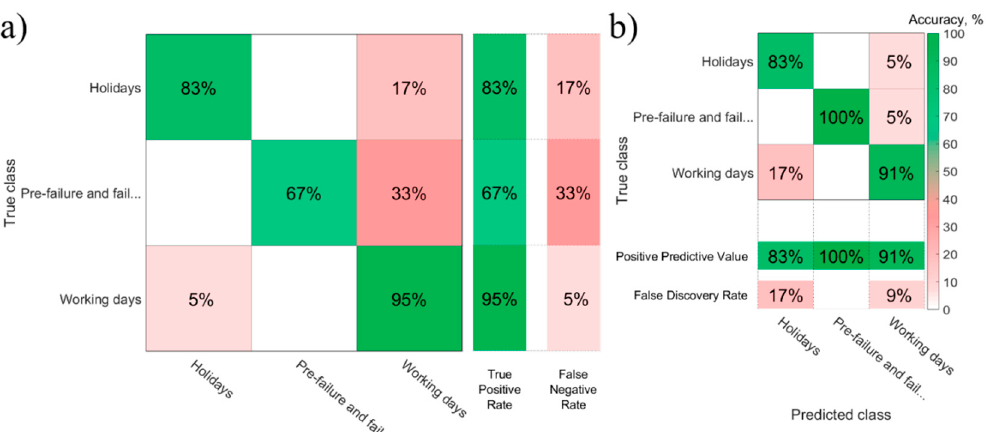
Figure 5. Error matrix of TPR and FNR ( a ) and Positive Predictive Value (PPV) and False Discovery